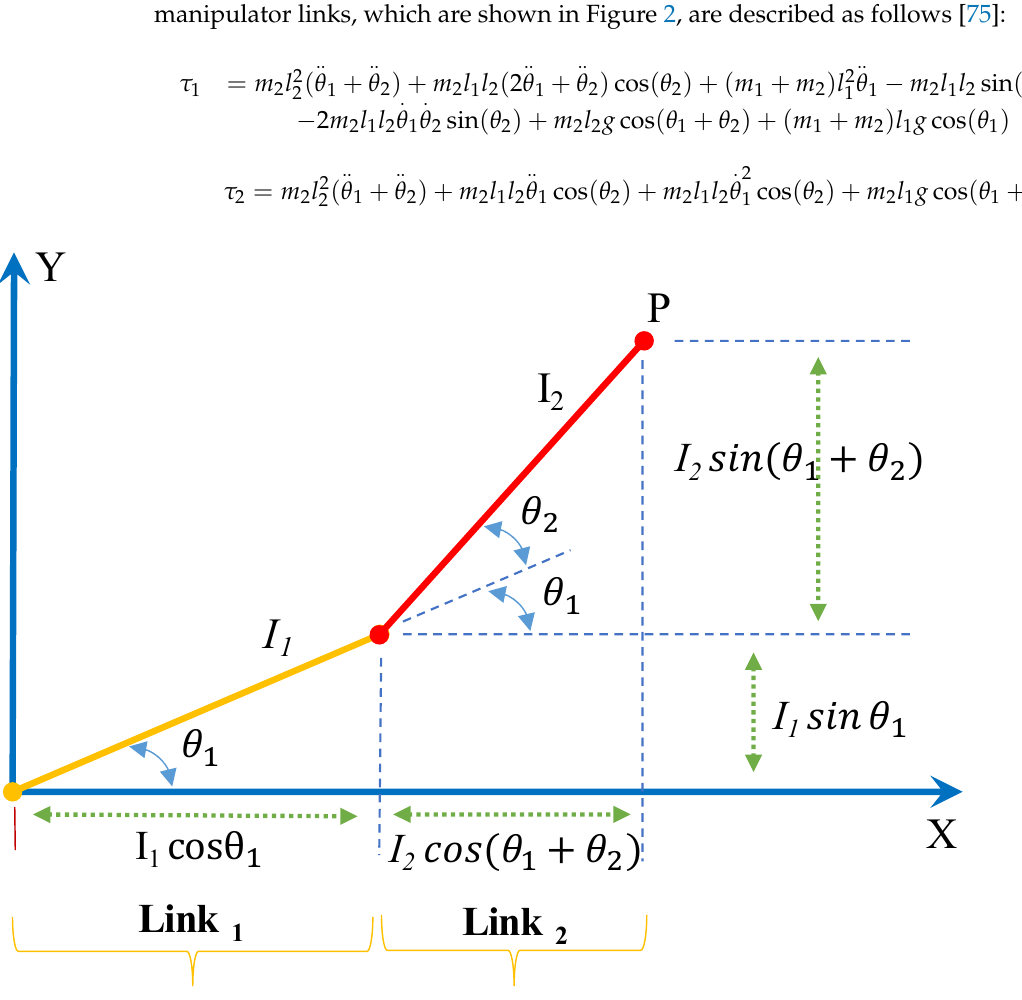
Figure 2. The geometric representation of two degrees of freedom robotic manipulator.